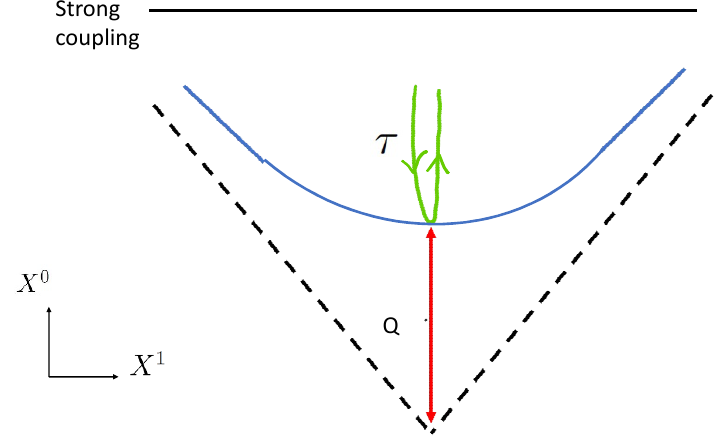
Figure 2 . The green line indicates the way the string folds which is always towards the strong coupling region. The tip of the string is always moving faster than light. It approaches the speed of light, the dashed lines, when j X 1 j is